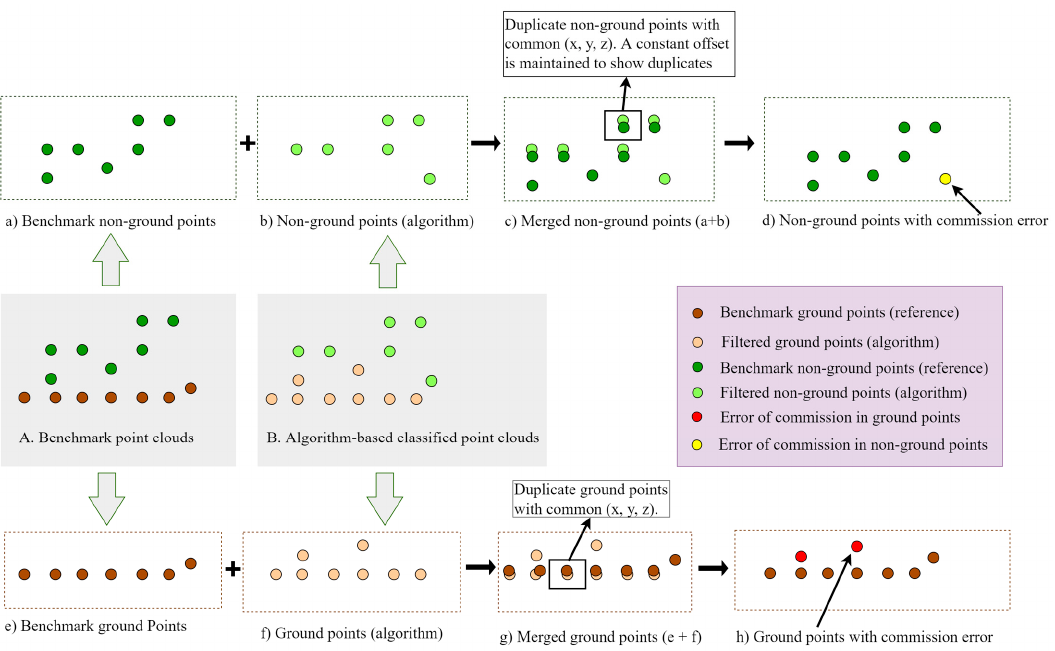
Figure 9. Automated workflow for calculating omission and commission errors in algorithm ‐ based classified point clouds: ( A ) Benchmark points. ( B ) Algorithm ‐ based classified points. ( a ) Benchmark non ‐ ground points class. ( b ) Algorithm ‐ based non ‐ ground points. ( c ) merged non ‐ ground points from ( a , b ) with duplicates. ( d ) Merged point clouds after removing duplicates. ( e ) Benchmark ground points. ( f ) Algorithm ‐ based ground points. ( g ) Merged ground points with duplicates. ( h ) Ground points without duplicates.